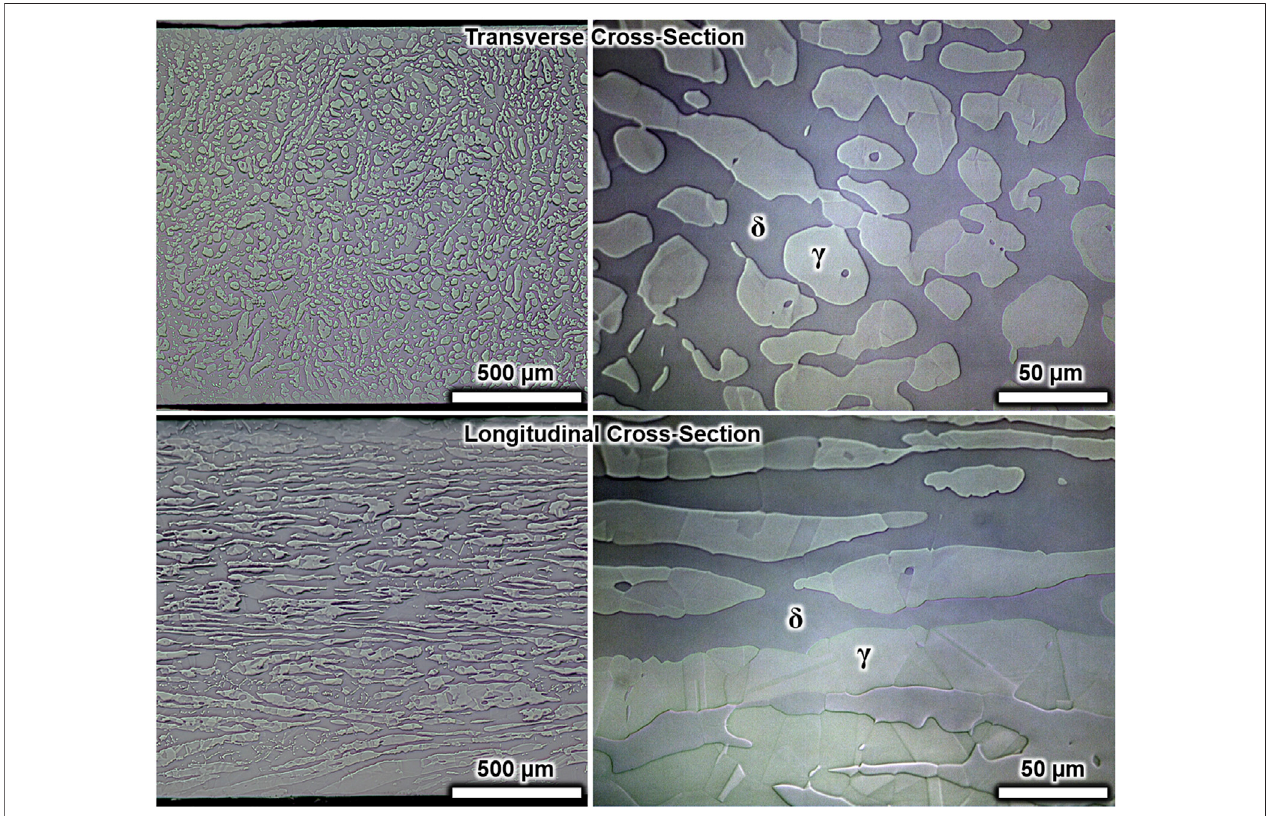
FIGURE 3 | Images showing the microstructure along the transverse and longitudinal cross-sections. The ferrite phase ( δ ) is the matrix, whereas the austenite phase ( γ ) is embedded as islands in the ferrite matrix. The rolling direction is along the horizontal axis in the bottom two micrographs (longitudinal).